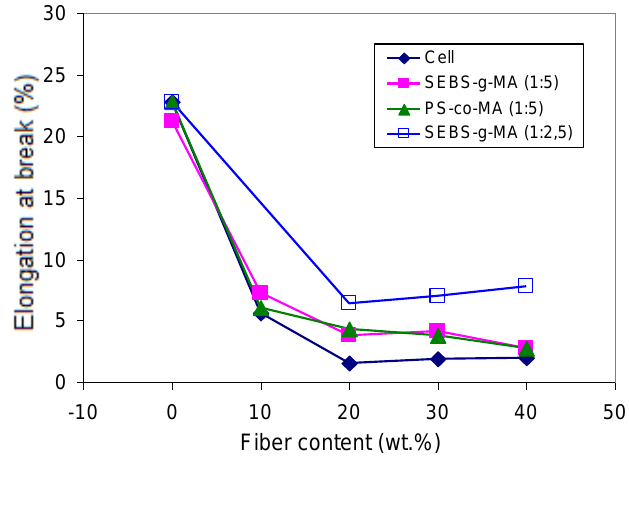
Figure 14. Effect of cellulose content on the elongation at break of PS/Cell composites containing PS- co -MA and SEBS- g -MA (at different copolymer/fiber